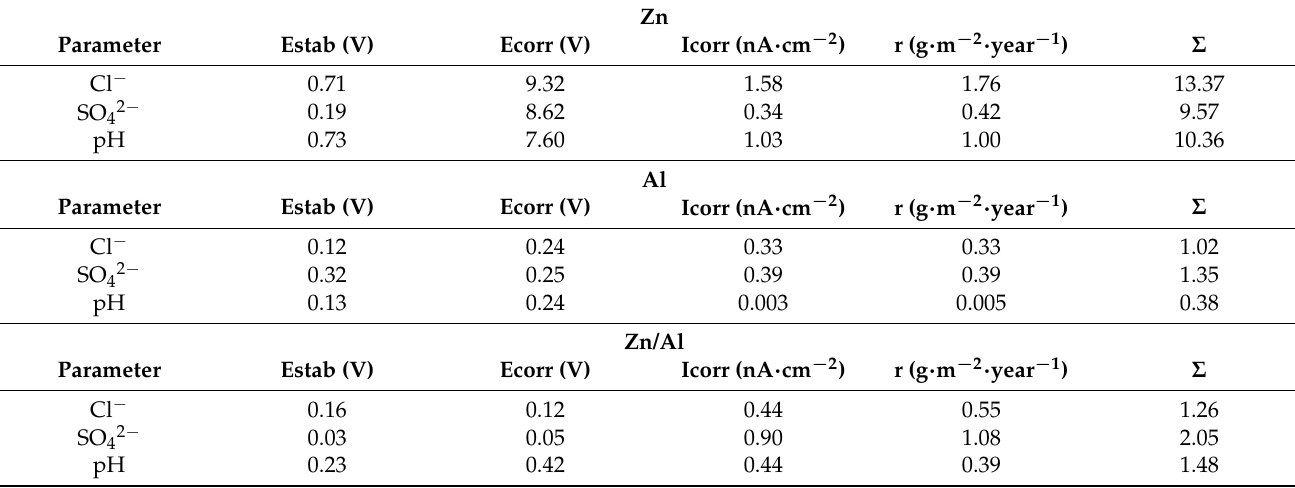
Table 7. t -Student coefficients for the influence of parameters of